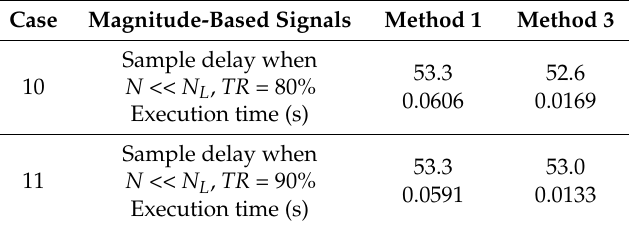
Table 5. Estimated sample delay and program execution time for a vehicle that traveled at 33.3 km/h (threshold as a percentage of maximum peak value in the first signal).